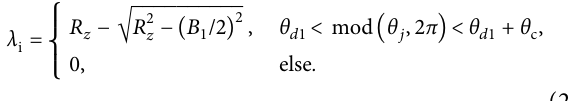
Figure 9: Schematic diagram for spalled gear tooth.